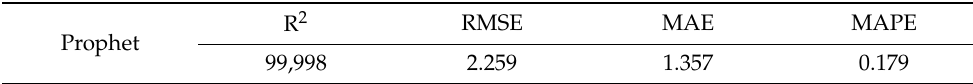
Table 7. Performance metrics of the Prophet method.